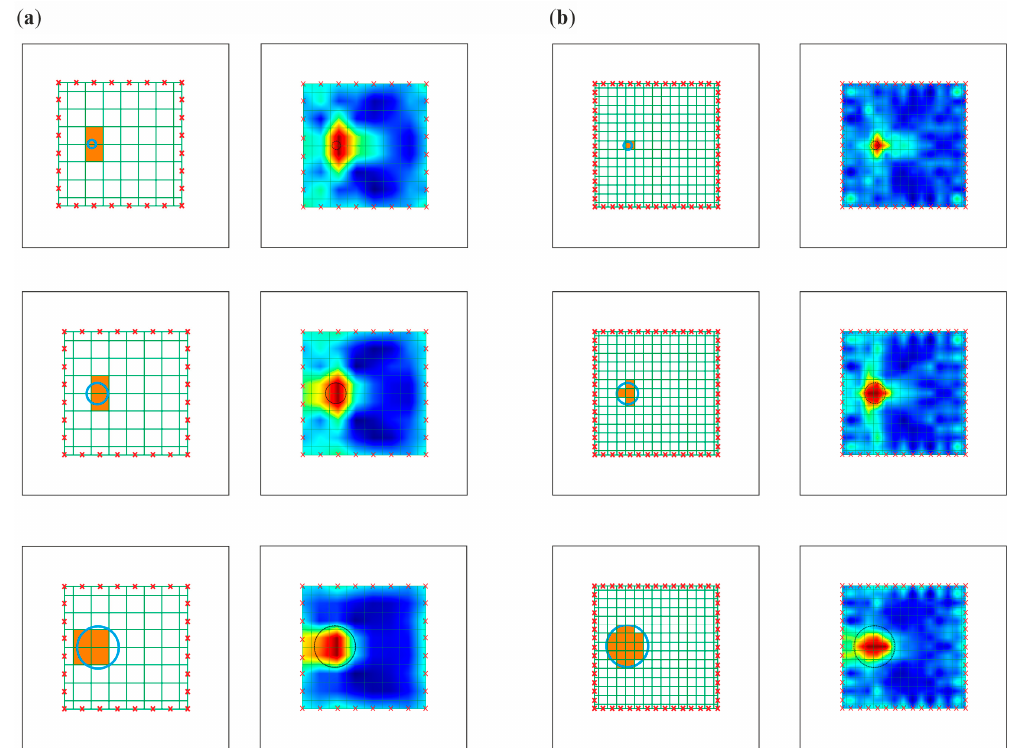
Figure 16. Pixel grid for travel time difference method ( a ) division into 64 pixels; ( b ) division into 225 pixels.